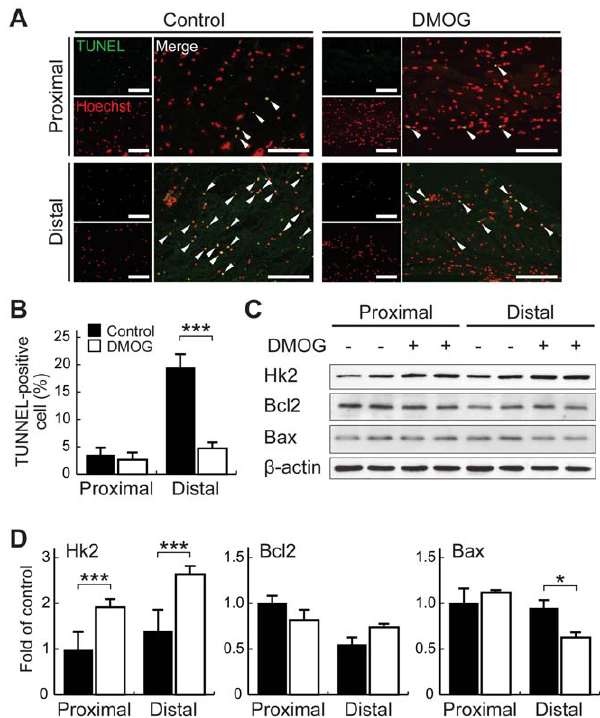
Figure 5. Effects of DMOG pretreatment on apoptosis in the mouse skin flap model. A, The apoptotic cells in the proximal and distal parts of the skin flaps taken on postoperative day 1 from mice with or without DMOG pretreatment were detected by TUNEL staining. Sections of the skin flaps were stained for TUNEL (green) and Hoechst (red). Scale bar indicates 100 m m. B, The ratio of TUNEL-positive cells to cell nuclei in the sections was calculated. Values are means 6 SEM. *** P , 0.001. C and D, Evaluation of expression of apoptosis-related factors in BALB/c mice. HK2, BCL2, and BAX protein expression levels in the proximal and distal parts of the skin flaps harvested on postoperative day 1 were detected by immunoblotting of protein